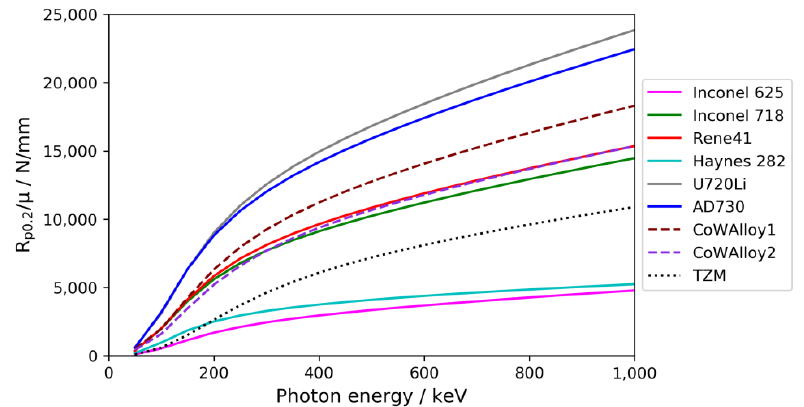
Figure 3. Calculated ratio of yield strength R p0.2 at 650 °C and linear attenuation coefficient µ as a